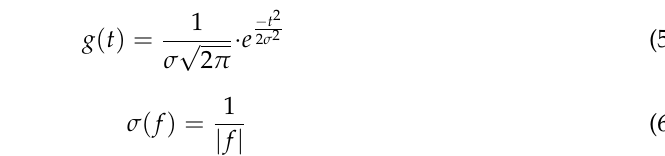
Figure 3. Flow chart of harmonic signal detection and classification.